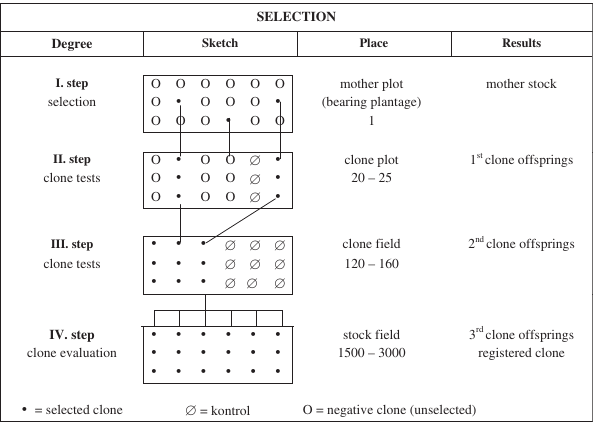
Table 1. IV. step clonal selection method of Németh